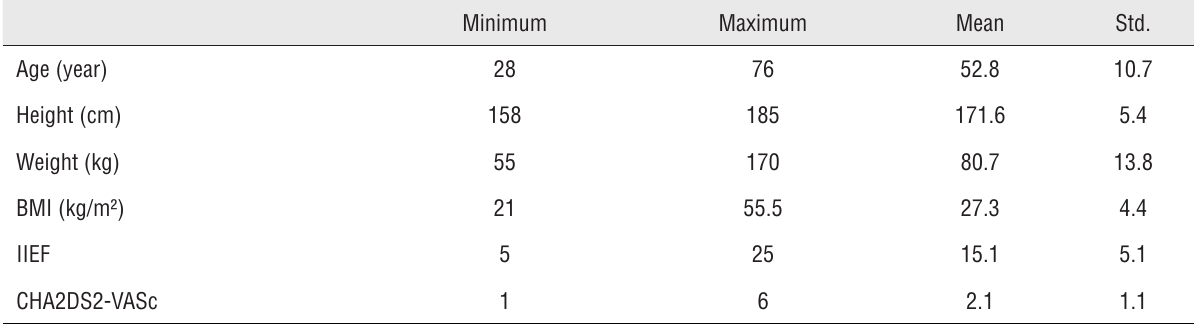
Table 1 - The clinical and demographic data.